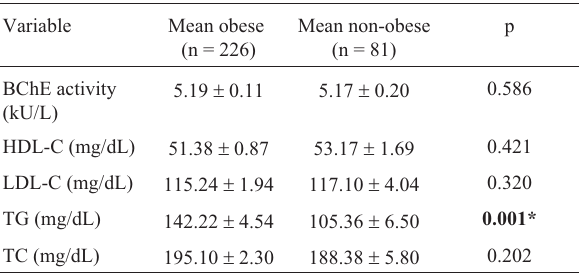
*Significant value in bold type. BChE: Butyrylcholinesterase TG: triglyc- erides, TC: total cholesterol, HDL-C: high density lipoprotein cholesterol, LDL-C: low density lipoprotein cholesterol.